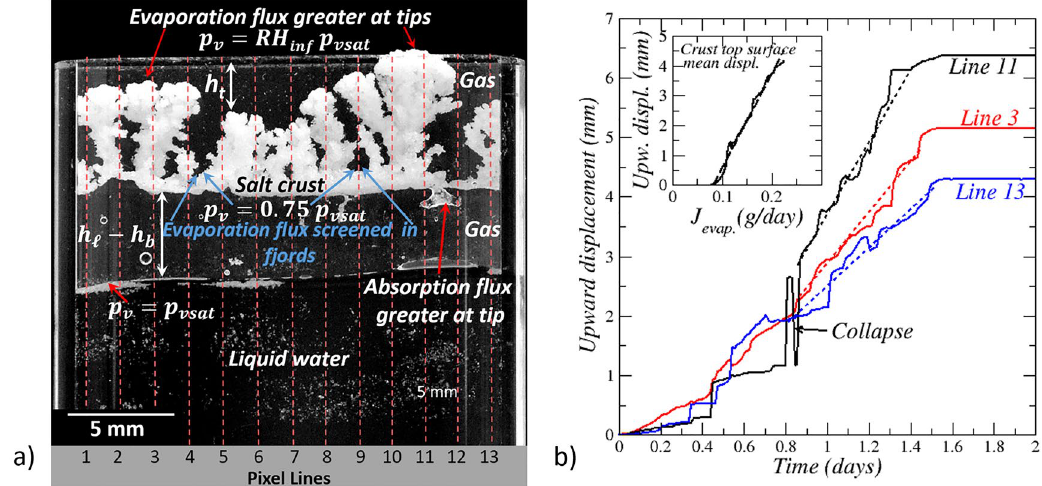
Figure 5. Evaporation flux distribution in stage 2. ( a ) Schematic of evaporation flux distribution at crust top surface and absorption flux distribution at crust bottom surface during the salt crust destabilization period; vertical pixel lines considered in the image processing (see the “Materials and Methods “section). It can be noted that the distance h t can be locally equal to zero since some fingers reach the cell top. The average distance over the vertical lines shown in the figure is however greater than zero, ( b ) salt crust top surface displacement along lines 3, 11 and 13 (selected because corresponding to finger tips). The inset shows the crust top surface mean displacement as a function of the evaporation rate (up to day